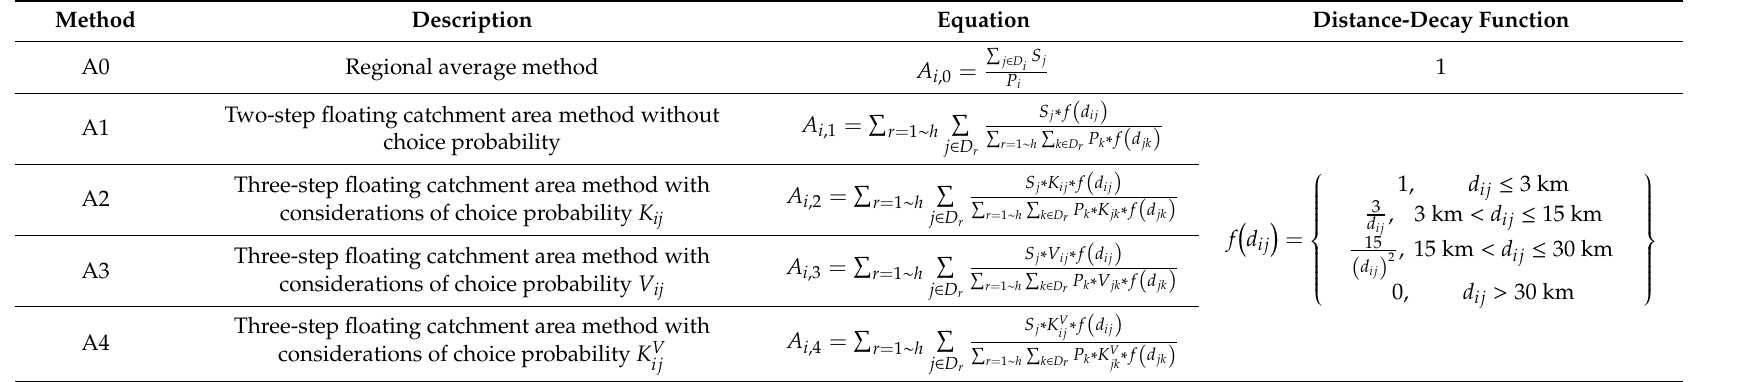
Table 1. Definition of elderly physical rehabilitation resources geographic accessibility